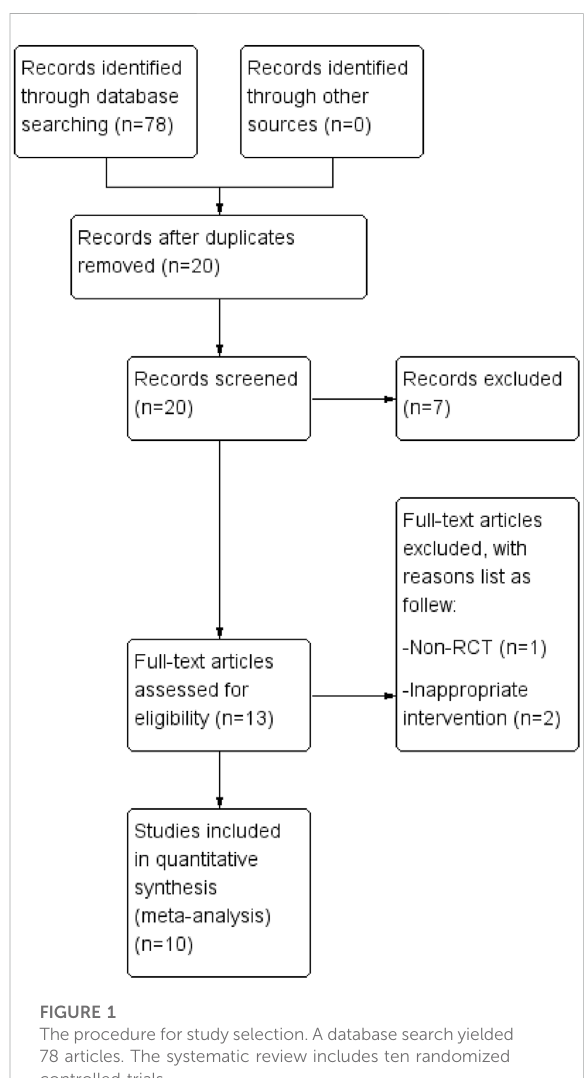
FIGURE 1 The procedure for study selection. A database search yielded 78 articles. The systematic review includes ten randomized controlled